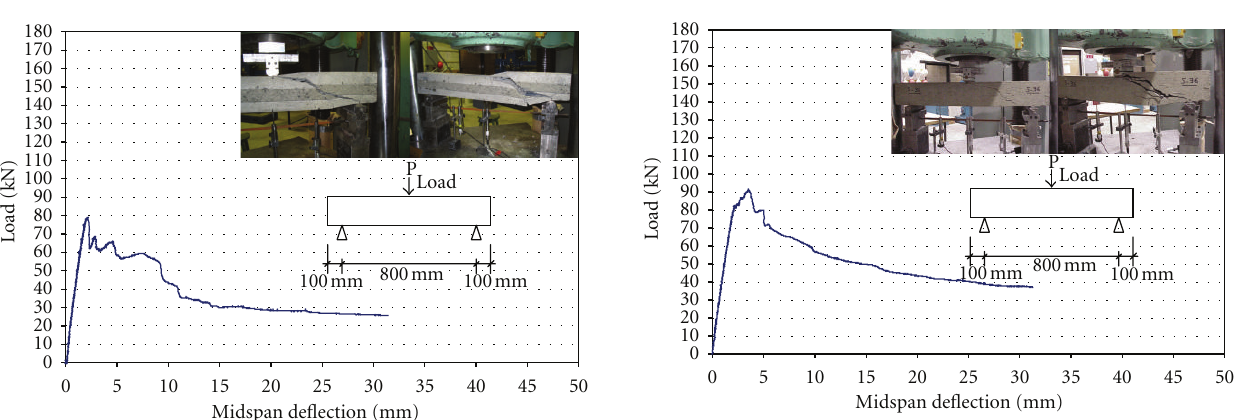
Figure 3: Load versus midspan deflection of control RC beam C-NS.